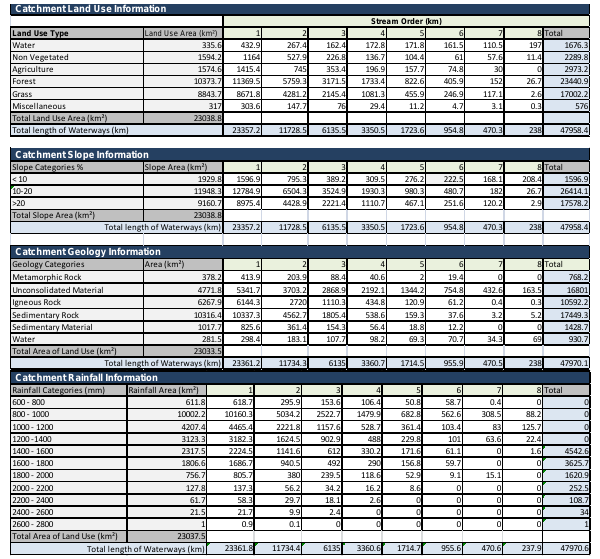
Figure 7, Model Deducted from Results 5.